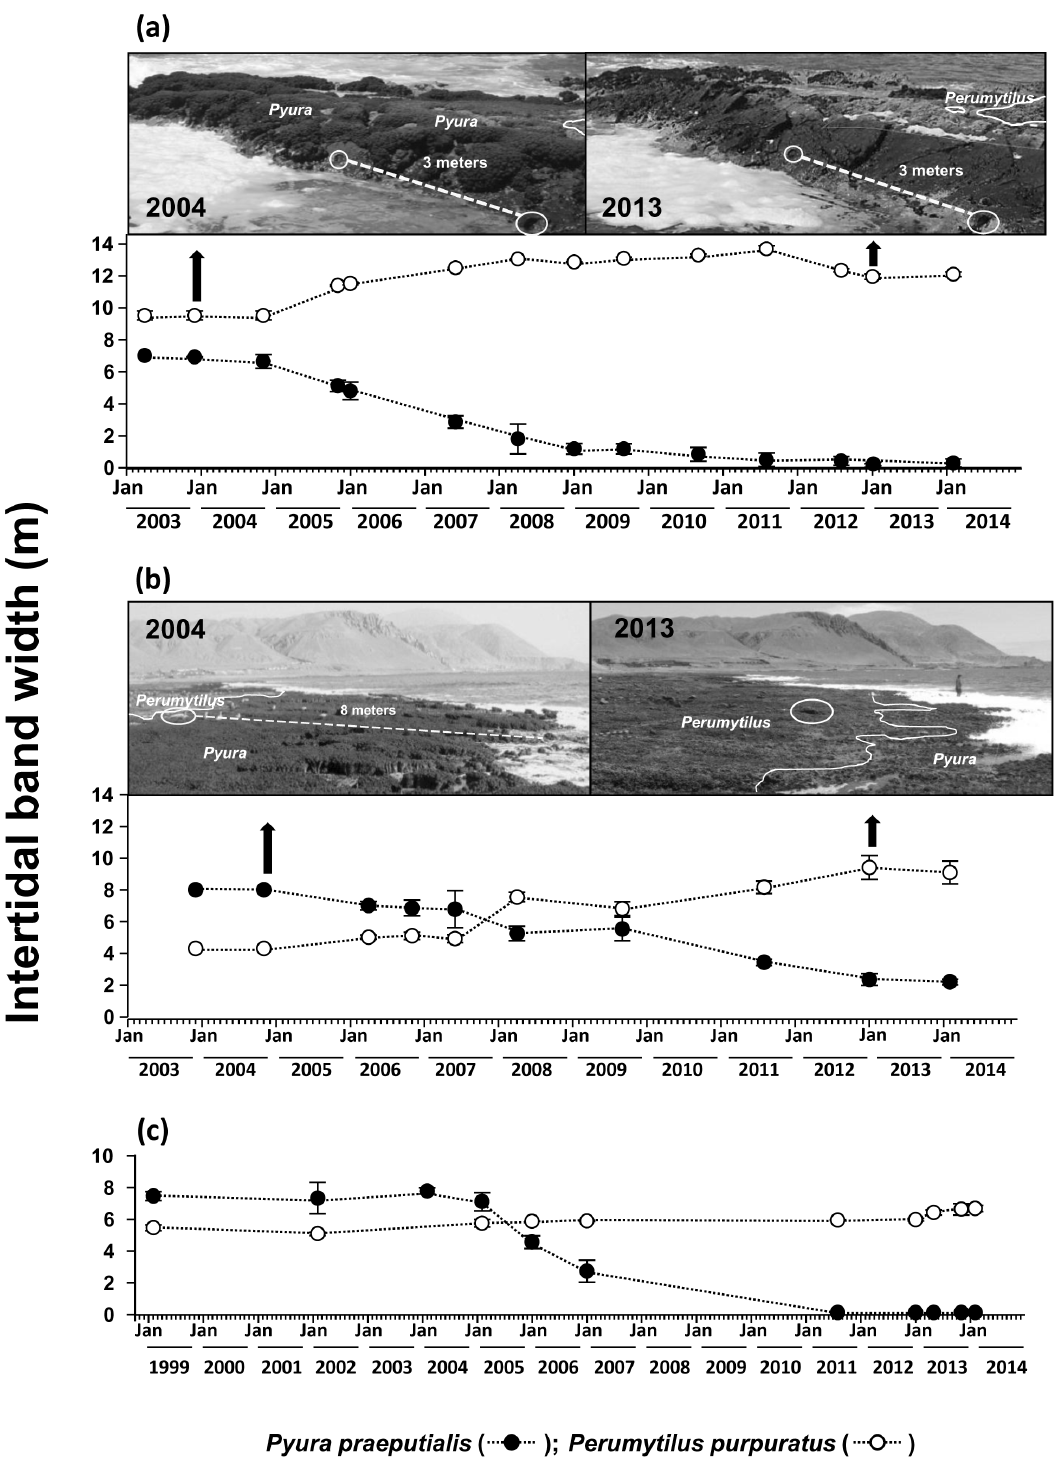
Figure 4. Temporal series of mean intertidal band width (m; SE) of the tunicate Pyurapraeputialis (black circle) and the mussel Perumytiluspurpuratus (white circle) in the bay of Antofagasta between April 2003 and February 2014 for a site at AAA (a) and a site at El Way (b) and between February 1999 and February 2014 for El Lenguado (c). For further details see text. doi:10.1371/journal.pone.0110301.g004 summer to 0.38 km 2 1 in winter (Fig. 6). At four intertidal sites (C. Pyura -gathers ranged between 0.5–4.5 km 2 1 per low tide and the Coloso, El Way, AAA and Trocadero; Fig. 1), monitored during gathering excursion lasted from 6 to 120 min (Table 1). At these summer months (2009–2014), the mean abundance of professional sites Pyura -gathers, using knives and blade hand-saws, extracted